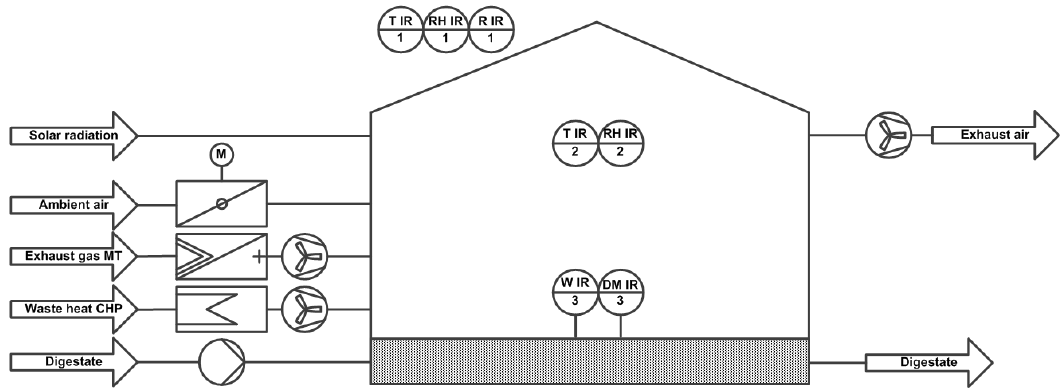
Figure 1. Scheme of the hybrid waste-heat/solar dryer with measuring-points for temperature (T), rel. humidity (RH) with continuous recording (IR).